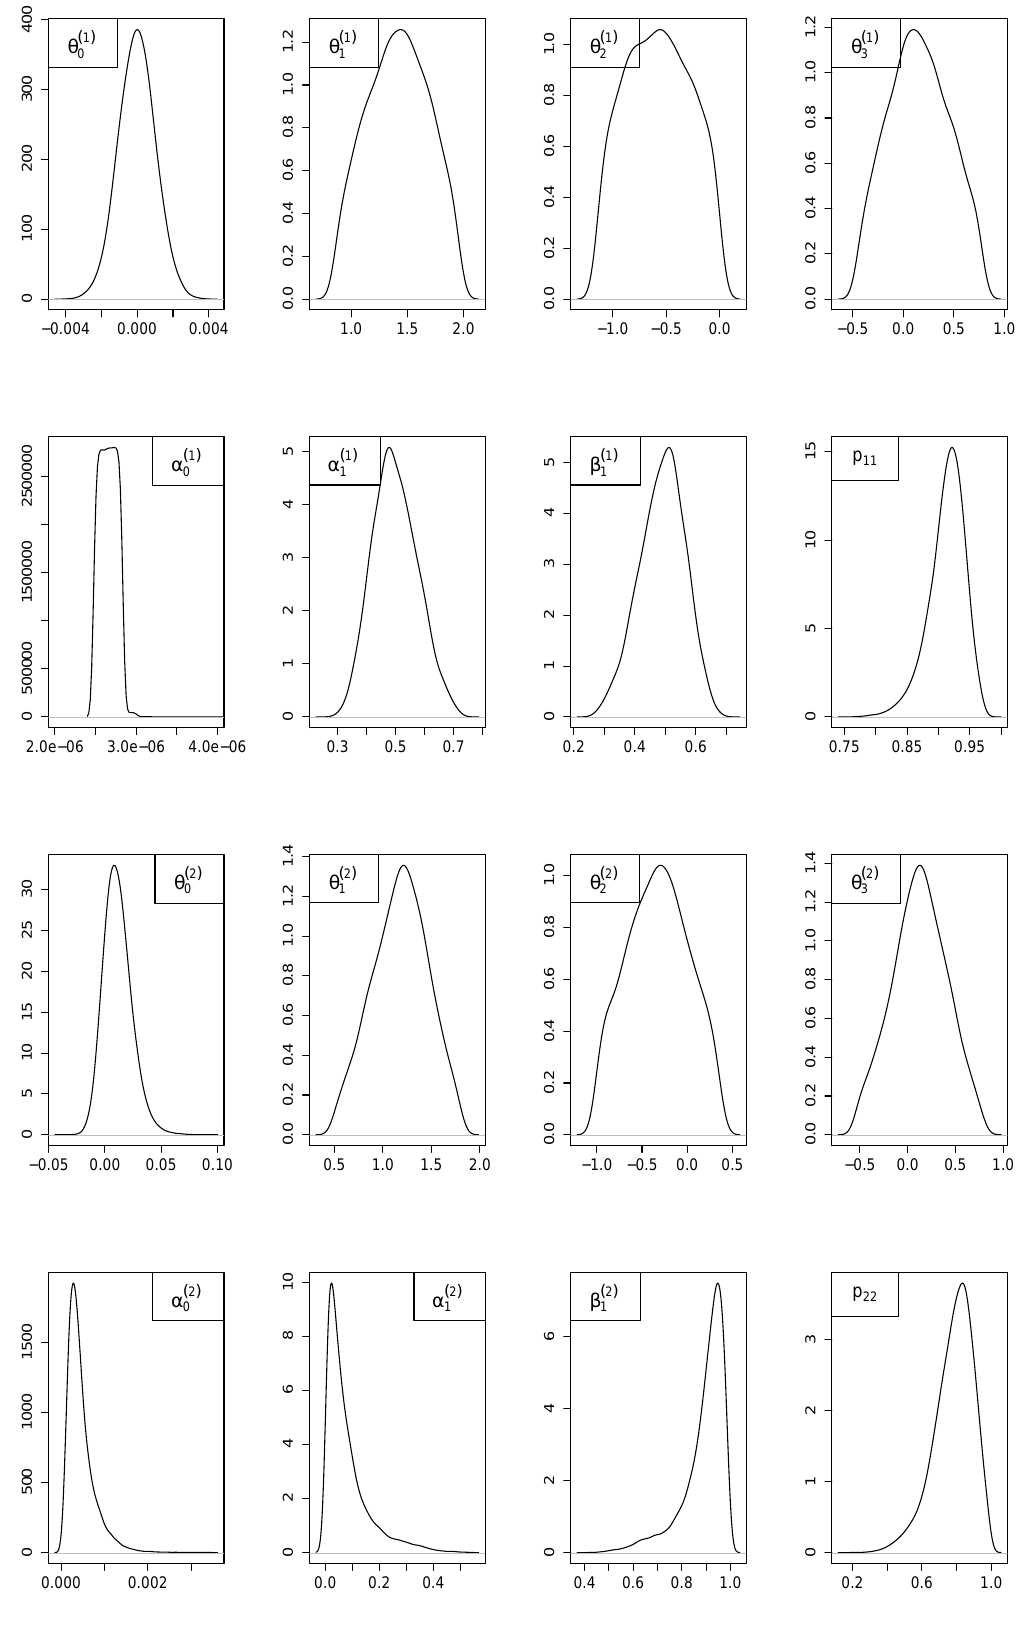
Figure 6. Estimated posterior densities of the MS(2)-AR(3)-GARCH(1,1) model fitted to the time series of wind